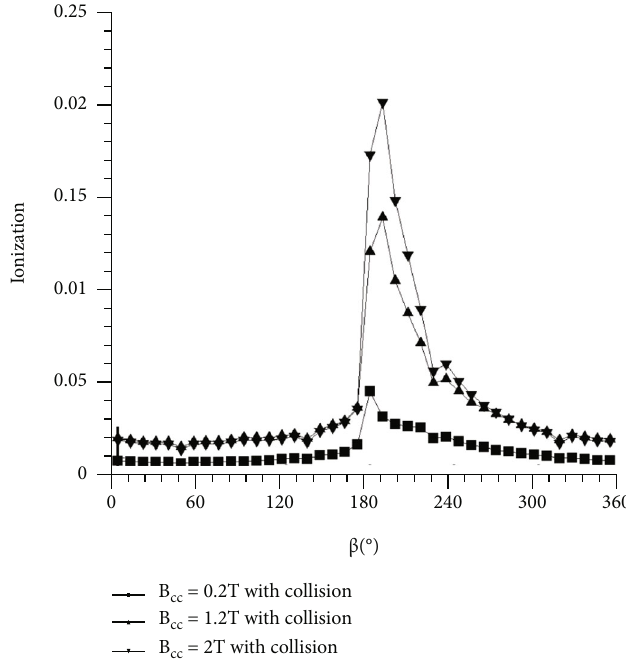
Figure 21: The change of ionization rate along the circumferential